Question: Provide a one-line summary of what is displayed.
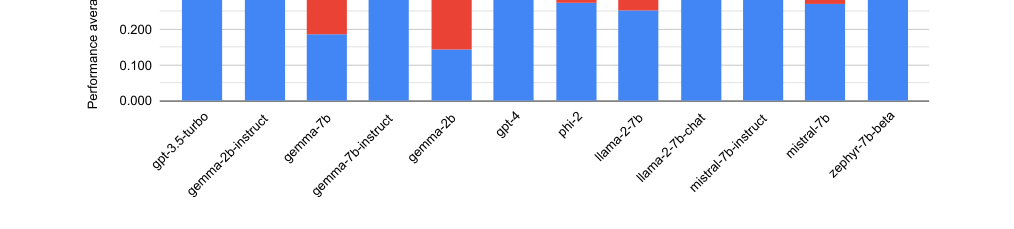
Answer: Average model performance for GPT-3.5, GPT-4, and 310 LLMs, before and after fine-tuning with LoRA, across 31 different tasks and 10 different base models. Zephyr-7b and Mistral-7b models exhibit the best performance after LoRA-based fine-tuning.